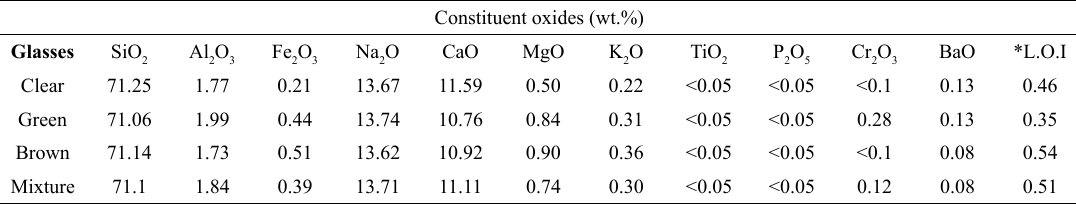
Table 1. Chemical composition of the investigated glasses determined by FRX analysis. Constituent oxides